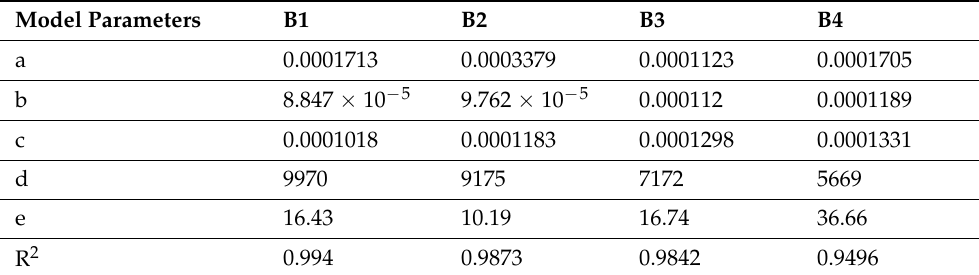
Table 5. Model parameter with fixed values for f l 0 and f s 0 , for batteries with a different C-rate.